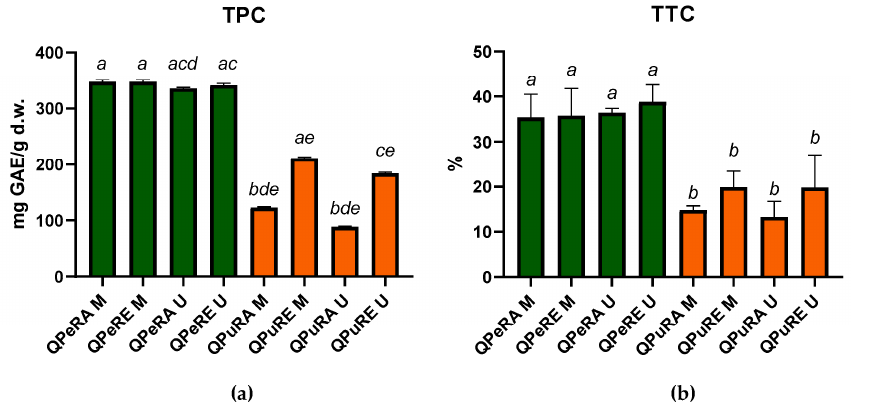
Figure 1. ( a ) Total phenolic content (TPC) of the oak bark extracts. ( b ) Total tannin content (TTC) of the bark extracts; different letters indicate significant differences. qPeRA M— Q. petraea bark extract obtained by aqueous MAE; qPeRE M— Q. petraea bark extract obtained by ethanolic MAE; qPeRA